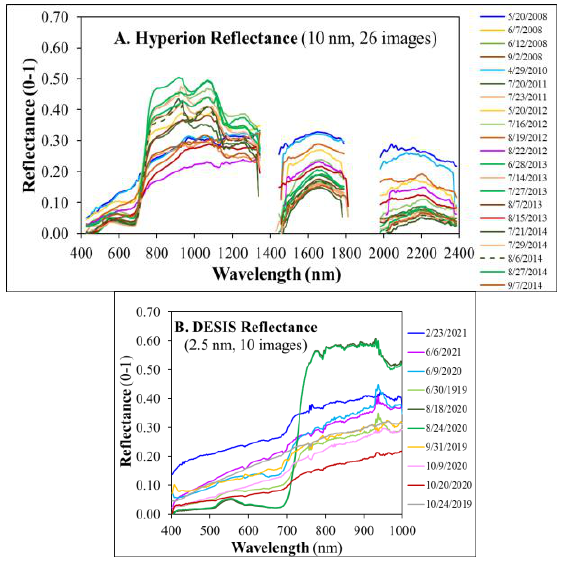
Figure 4. Seasonal variation in reflectance spectra at OPE3 as captured by Hyperion (A. VSWIR n=26) and DESIS (B. VNIR n=10) data.